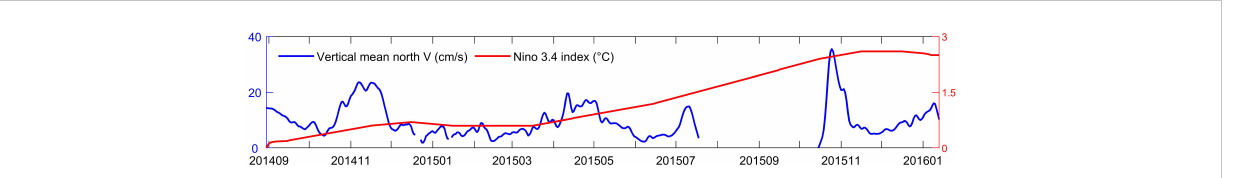
FIGURE 5 Time series of smoothed vertical mean north meridional velocity (cm s -1 ) (blue) and Niño 3.4 index (°C) (red) from August 2014 to January